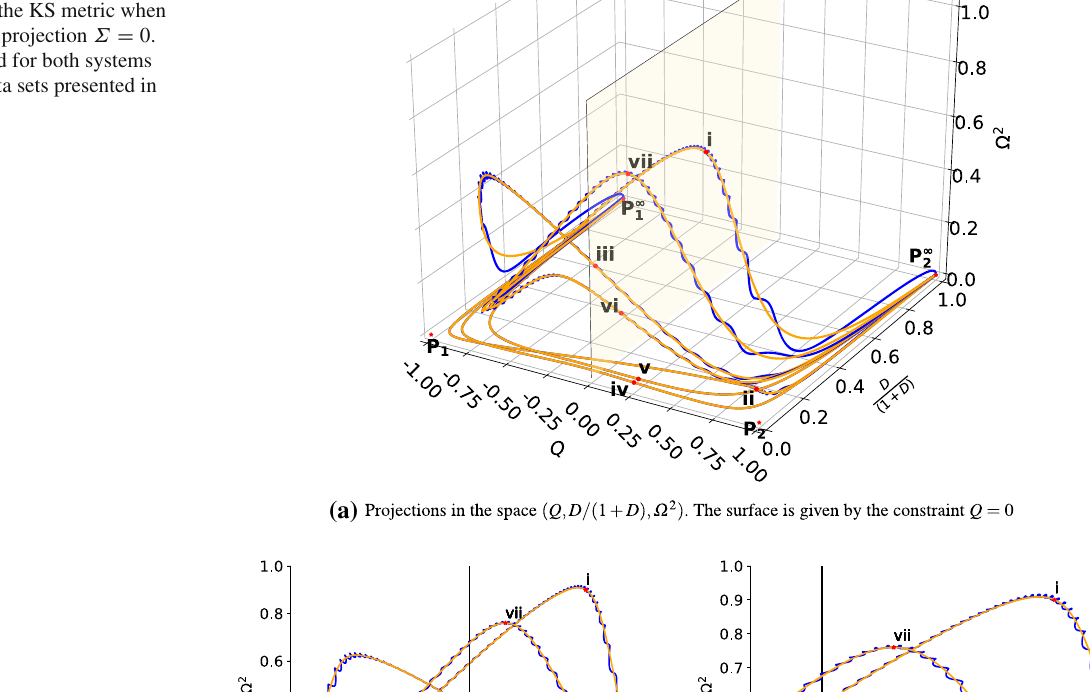
Fig. 16 Some solutions of the full system (93) (blue) and time-averaged system (127) (orange) for the KS metric when γ = 1 in the projection Σ =